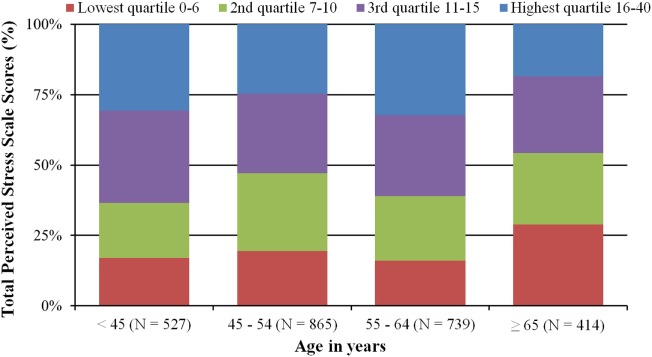
Testicular cancer survivors perceived stress scale (PSS) scores categorized in age groups and allocated into quartiles according to reference group quartile PSS scores.